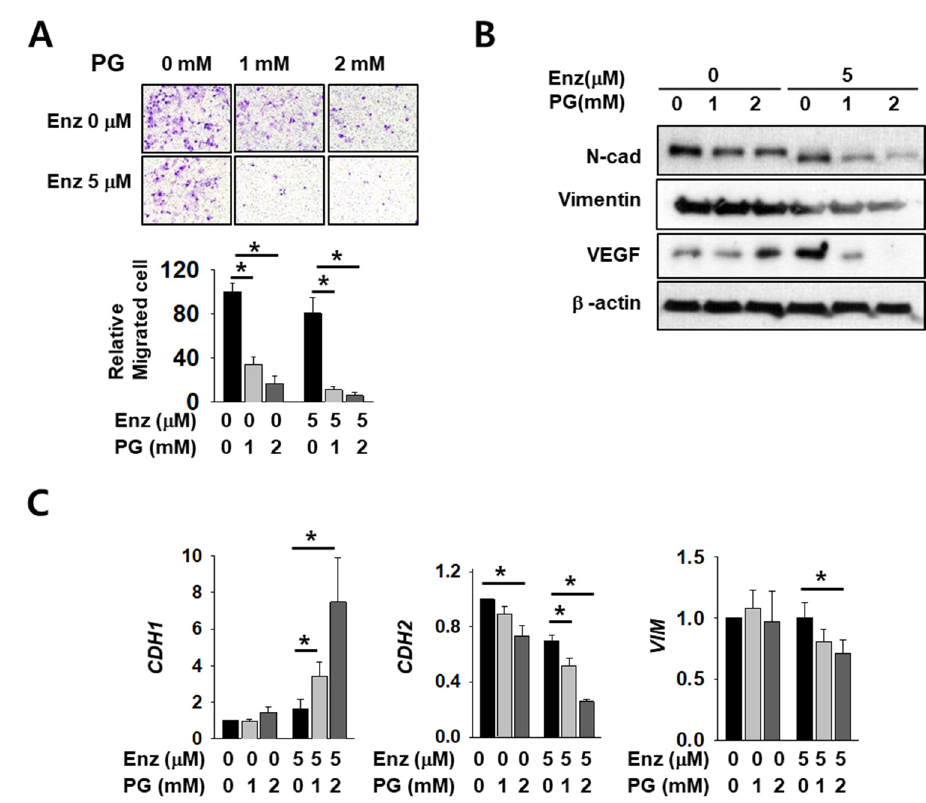
Figure 5. Pargyline treatment attenuates kidney cancer cell migration and decreases EMT marker expression. ( A ) The transwell infiltration assay of the same number of Caki ‐ 2 cells treated with indicated drugs observed after two days of incubation. Cells that had migrated to the underside of the filters were fixed and photographed. Graph presents the invasion rate as the mean percentage of control. Error bars represent the mean ± SD of three independent experiments and * denotes p < 0.05 (Student’s t ‐ test) between the two indicated groups. ( B ) Western blotting of indicated EMT marker proteins after two days of drug treatment in Caki ‐ 2 cells. Whole ‐ cell extracts were immunoblotted with indicated antibodies. ( C ) The mRNA levels of EMT marker genes were evaluated after 24 h of drug treatment in Caki ‐ 2 cells. Error bars represent the mean ± SD of three independent experiments and * denotes p < 0.05 (Student’s t ‐ test) between the two indicated groups.